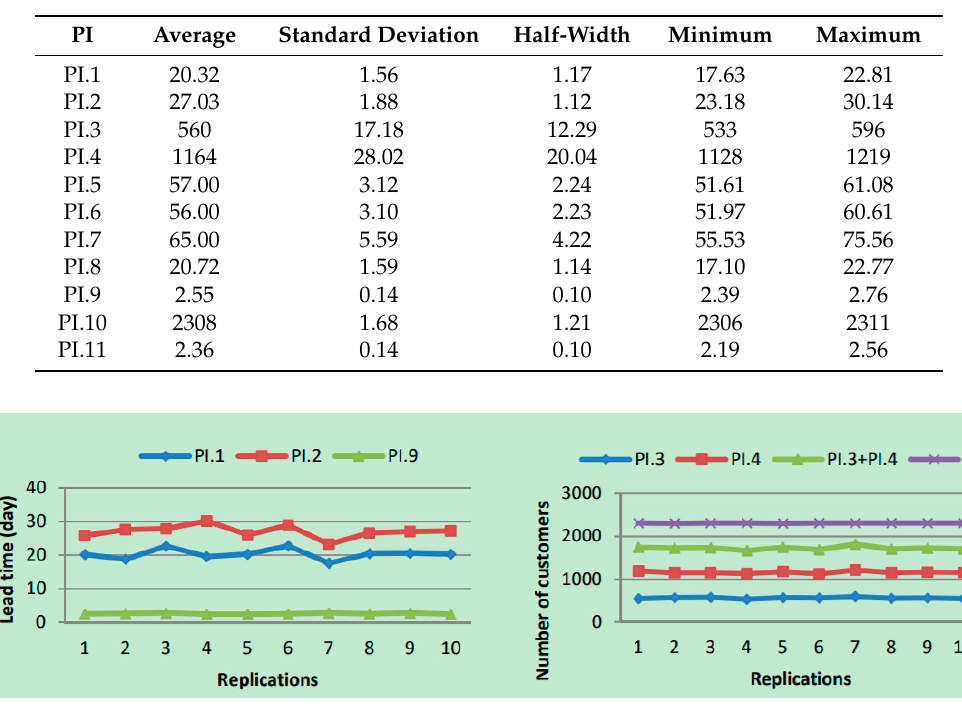
Figure 17. Comparison of two simulation models in terms of lead time and number of customers.